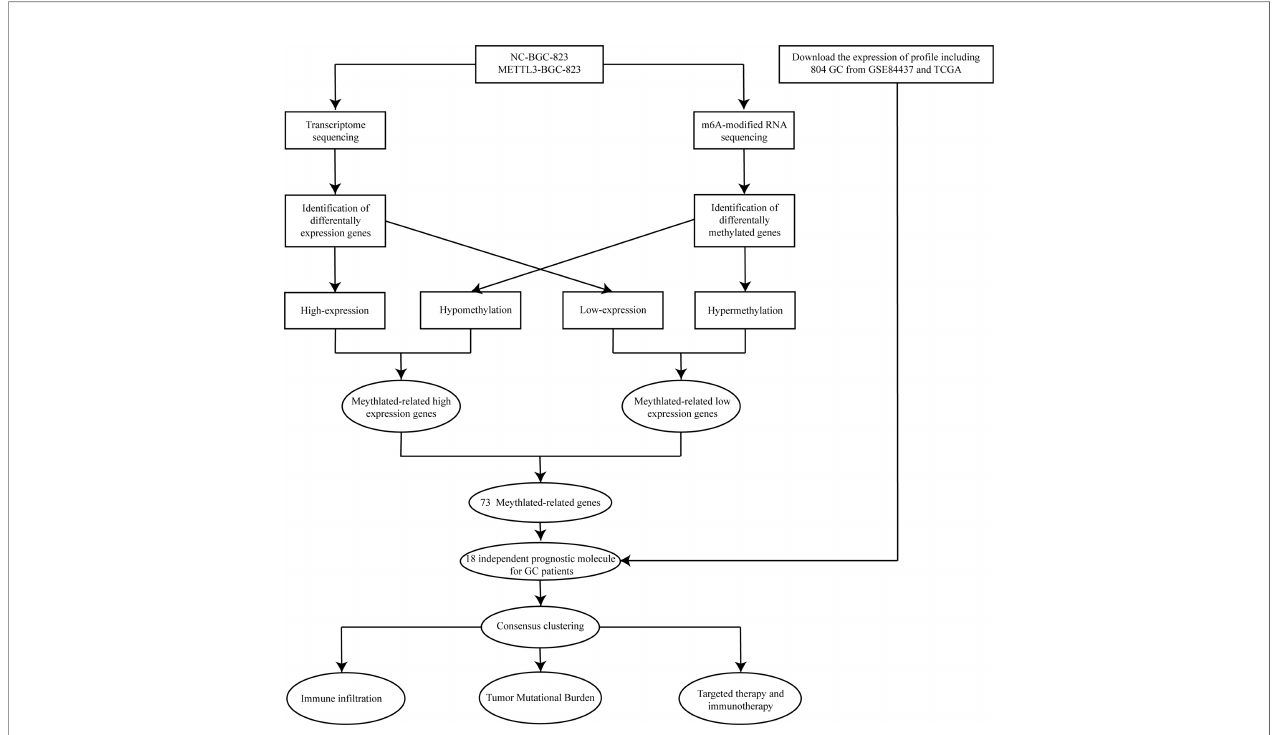
FIGURE 1 | The fl owchart showing the design of this